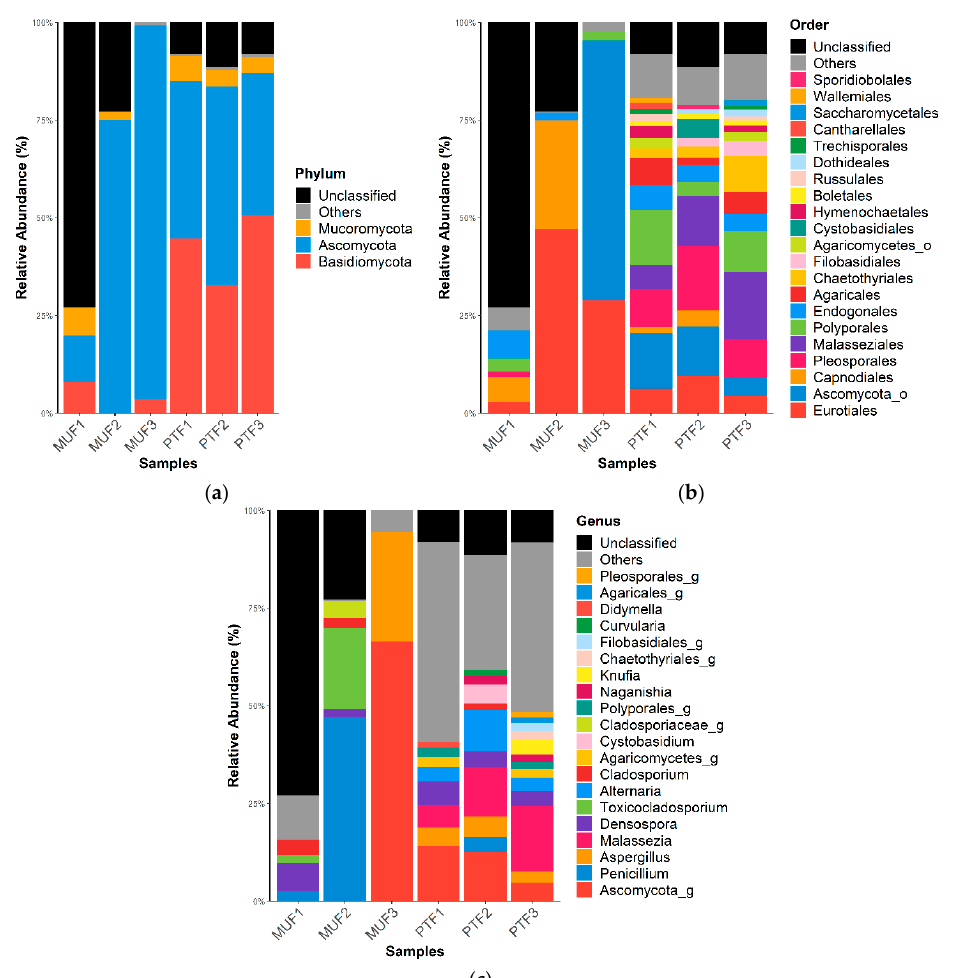
Figure 3. Fungal relative abundance (%) at the ( a ) phylum, ( b ) order, and ( c ) genus levels in MUF and PTF samples. The data are reported as relative abundances (%) of taxa with abundances of ≥ 1%.